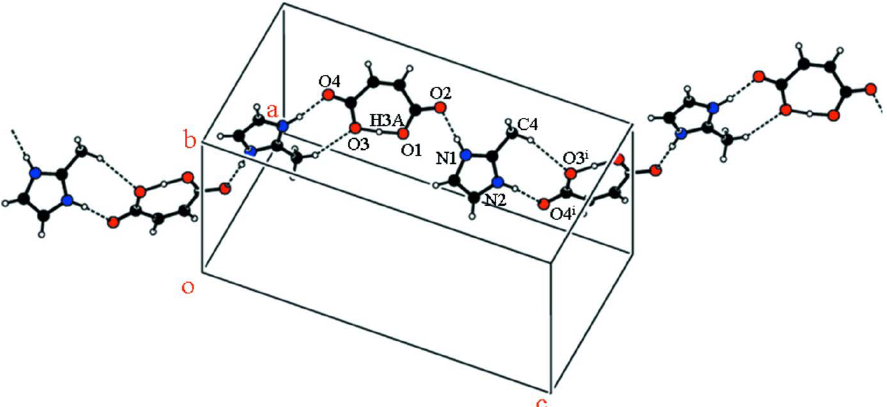
Figure 2 Part of the crystal structure of (I), showing the formation of the one-dimensional chain linked by intermolecular N-H···O hydrogen bonds parallel to the [101] direction. (symmetry code: i = 1/2+ x , 3/2- y , 1/2+ z